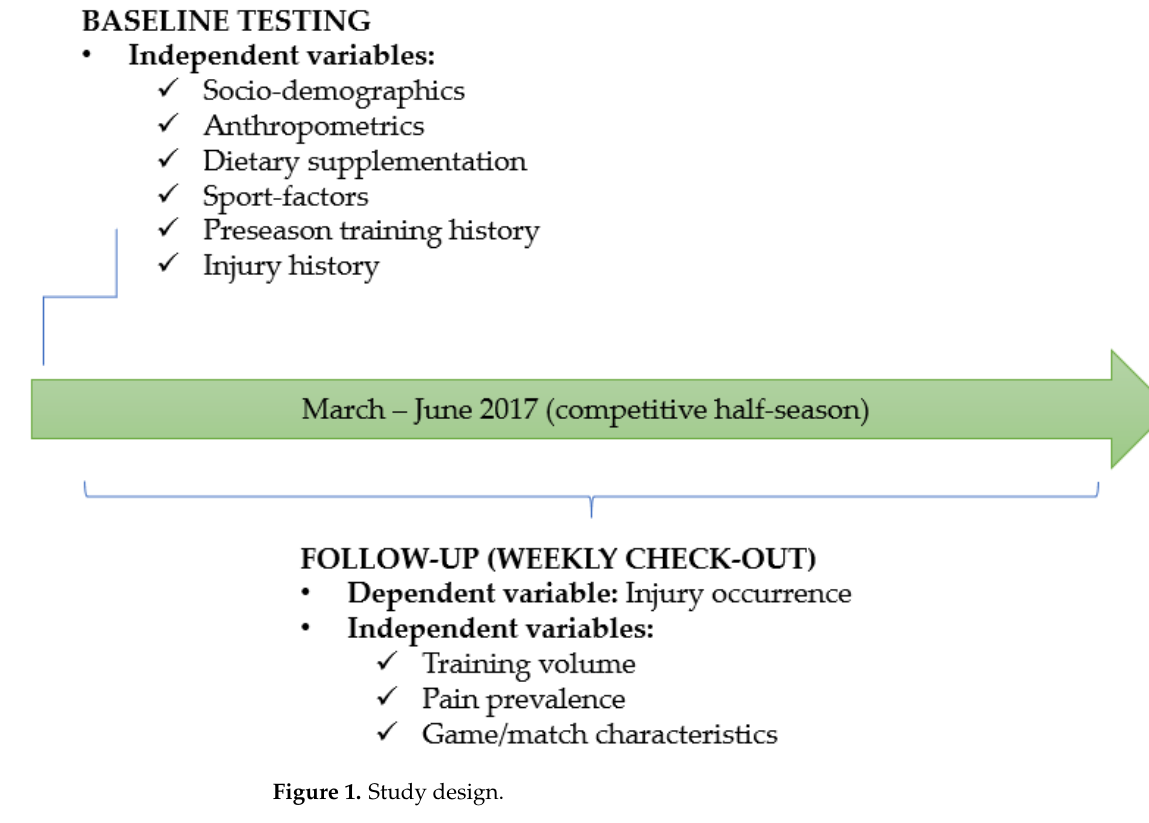
Figure 1. Study Figure 1. Study design.